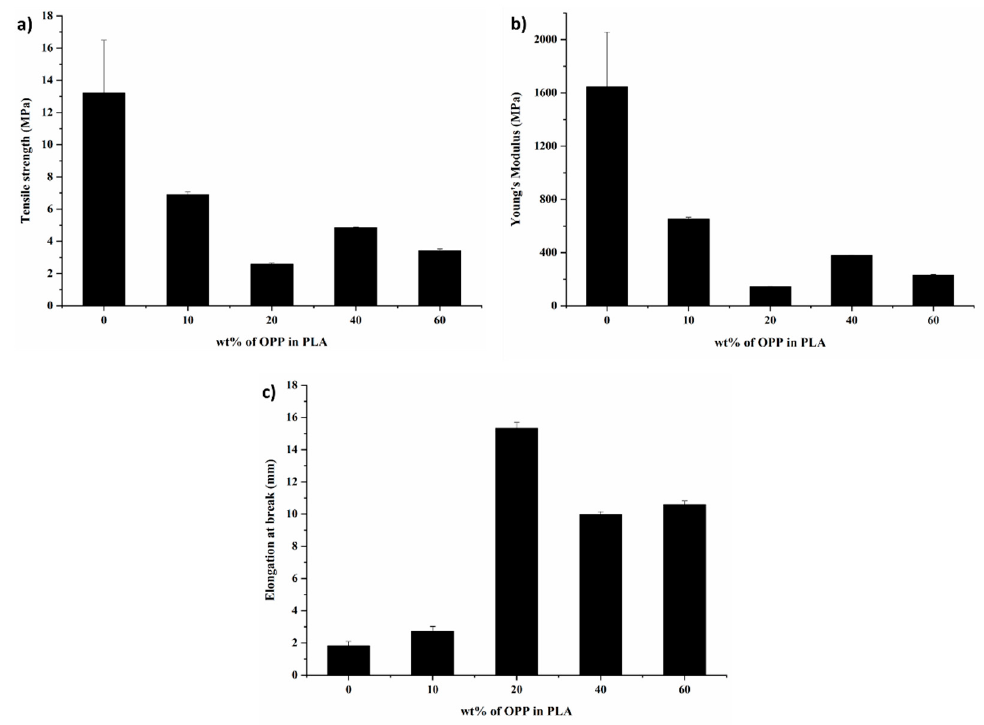
Figure 4. ( a ) Tensile strength, ( b ) Young’s modulus, and ( c ) Elongation at break of PLA, PLA/10 wt%, PLA/20 wt%, PLA/40 wt%, and PLA/60 wt% OPP composites.